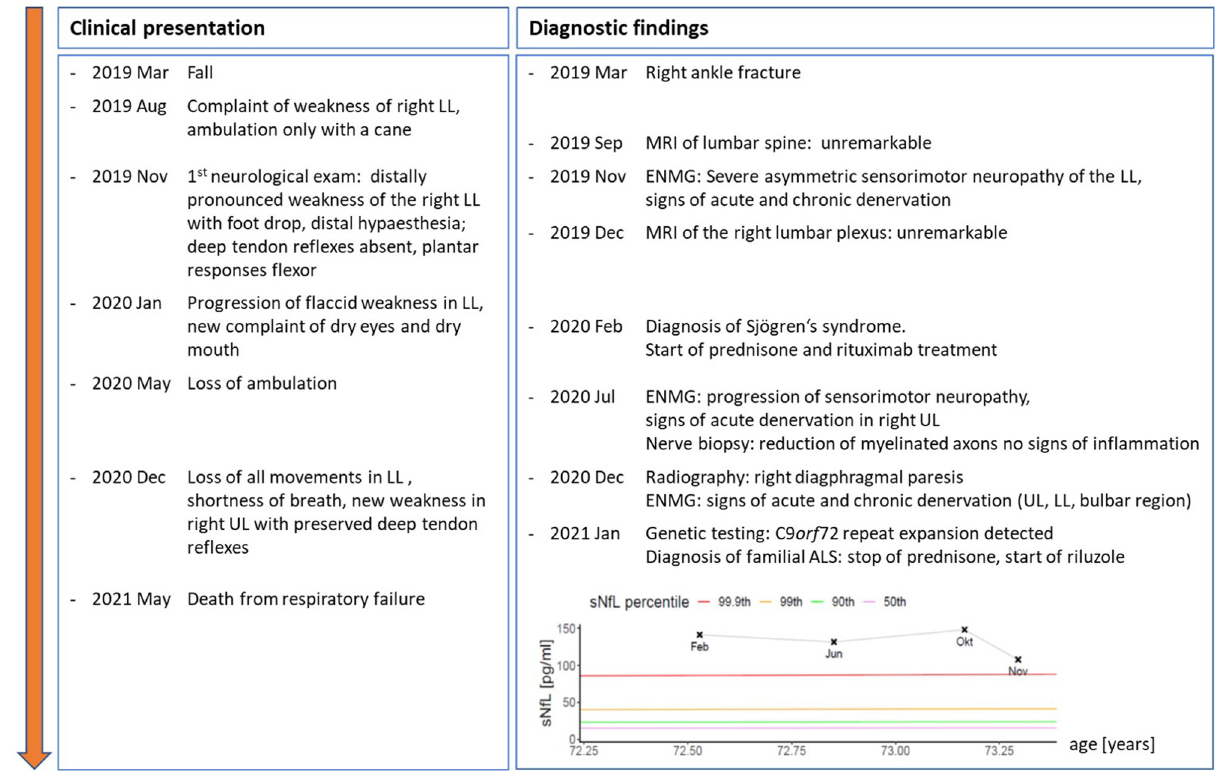
> 99.9th percentile (18)] indicating severe ongoing